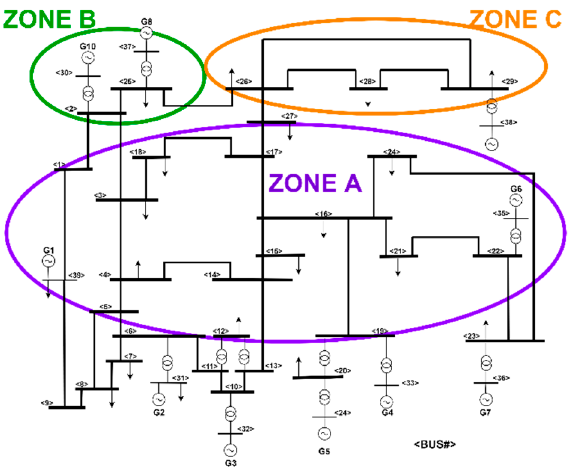
Figure 2. New England 39-bus system.